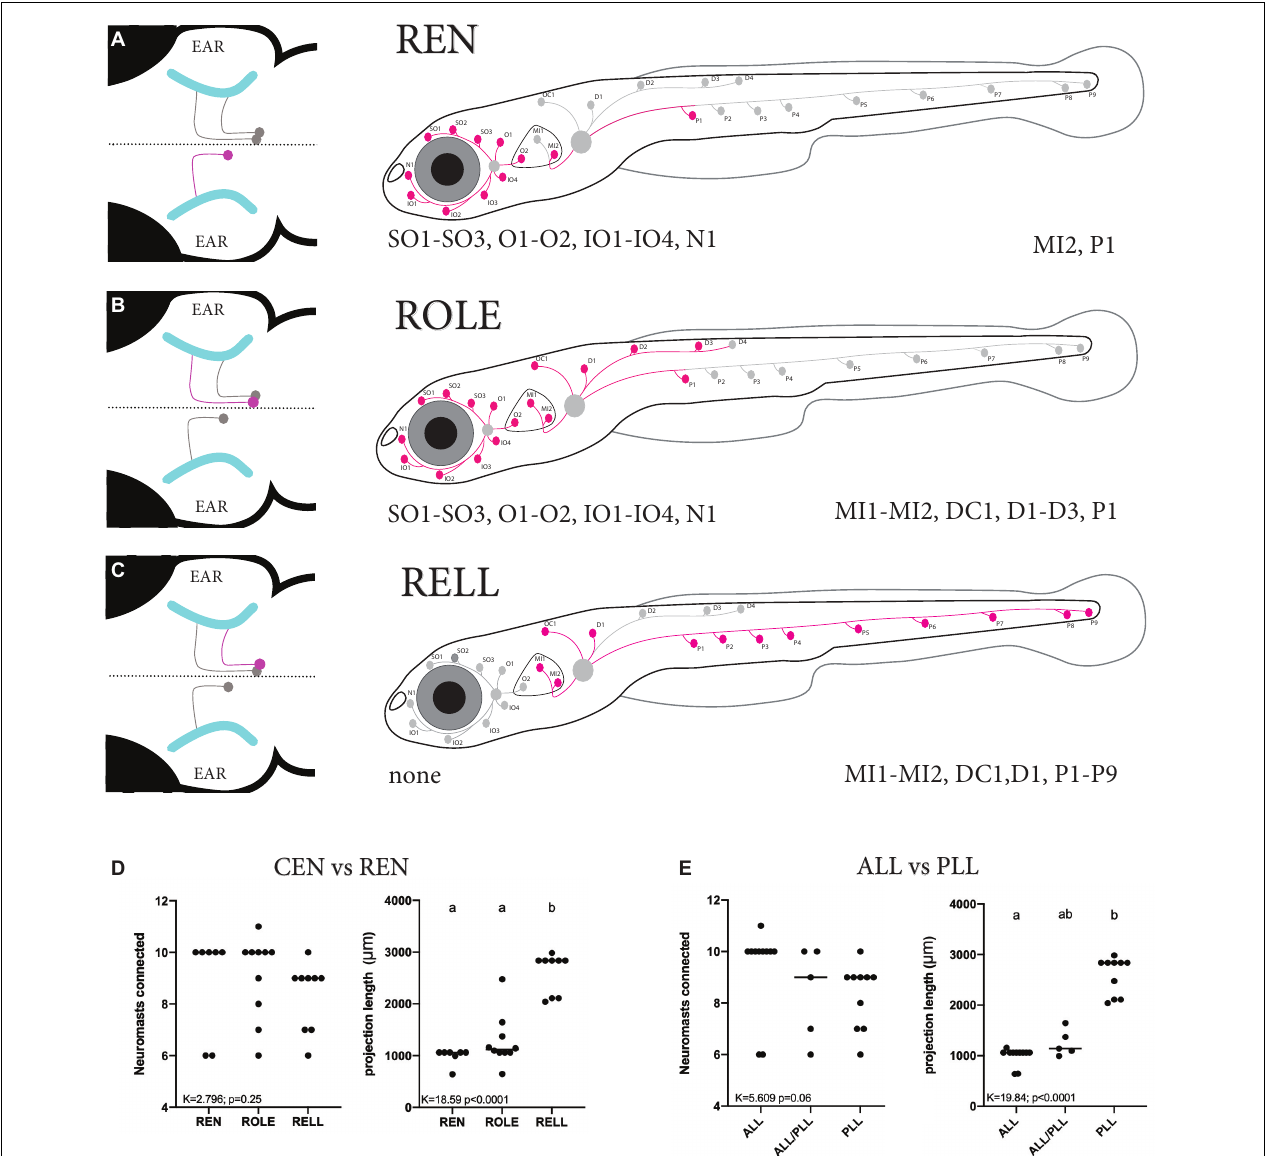
FIGURE 4 | Summary of the projection paths of individual inhibitory efferent cells. (A–C) Schematic zebrafish larvae showing the cumulative projection paths of REN ( n = 8), ROLE ( n = 10), and RELL ( n = 9) cells. Left drawing illustrates the projection paths of the REN, ROLE, and RELL cells (highlighted in magenta) within the rhombencephalon; projections of the sensory ganglion into the brain are shown in cyan. For each inhibitory efferent the cumulative projection path across the lateral line is highlighted (magenta) in the schematic zebrafish larvae on the right (for individual processes, please see Supplementary Figure 3 ). Identity of innervated neuromasts is listed below each schematic (left: anterior lateral line neuromasts; right: posterior lateral line neuromasts). (D) Quantification of the number of neuromasts connected revealed no significant differences between REN, ROLE, and RELL cells ( K = 2.789, p = 0.25). The total length of the projections made by the RELL cells was significantly longer compared to that of the REN and ROLE cells ( K = 18.59, p < 0.0001). (E) No significant differences were found between the number of neuromasts connected by individual inhibitory efferent cells that project to the ALL only, ALL and PLL, or PLL only ( K = 5.609, p = 0.06). The total length of the projections made by cells that connect in the PLL was significantly longer compared to those connecting to the ALL but not the ALL+PLL ( K = 16.84, p < 0.0001). Age of larvae: 5dpf. ALL, anterior lateral line; PLL, posterior lateral line; REN, the rostral efferent nucleus; CEN, the caudal efferent nucleus nucleus; ROLE, the rhombencephalic octavolateral efferent neuron; RELL, the rhombencephalic efferent neuron to the lateral line.